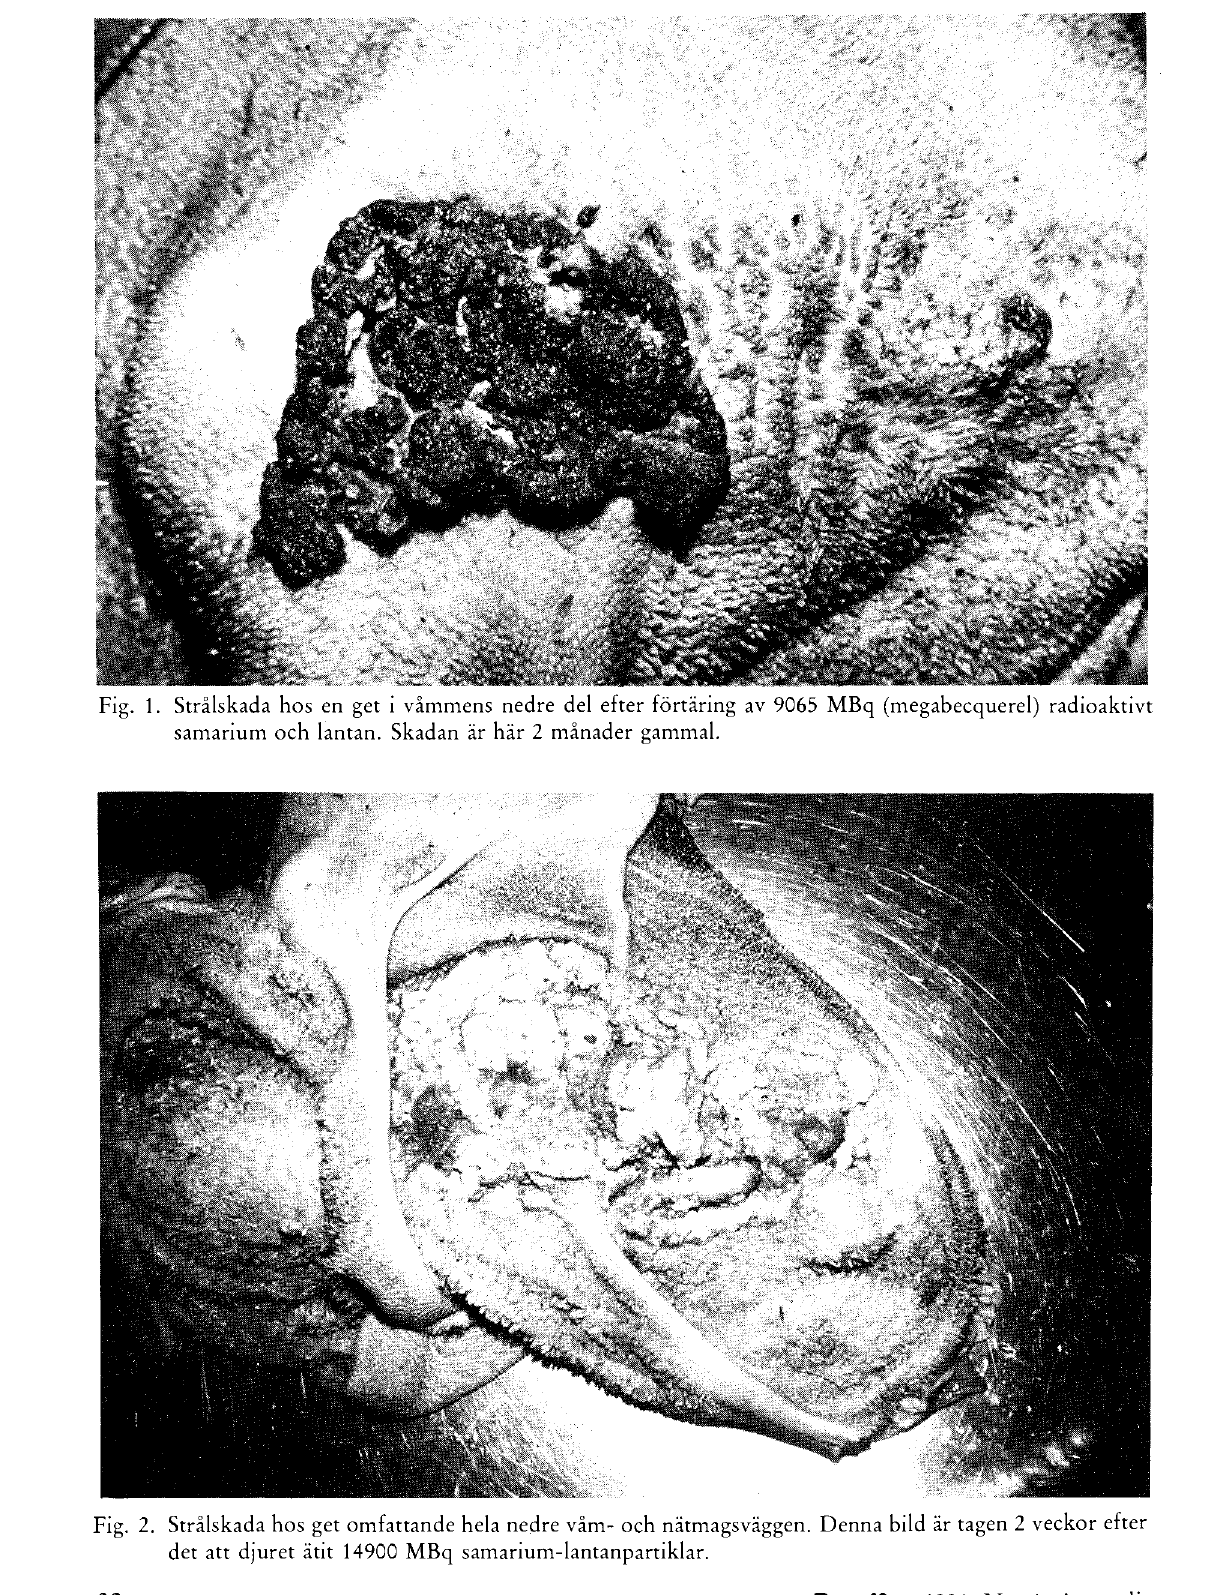
Rangifer, 1986, No. 1.